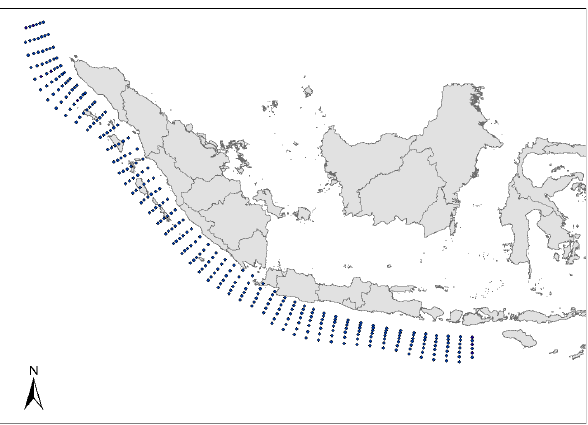
Fig. 7. Area of simulation coverage with AWI